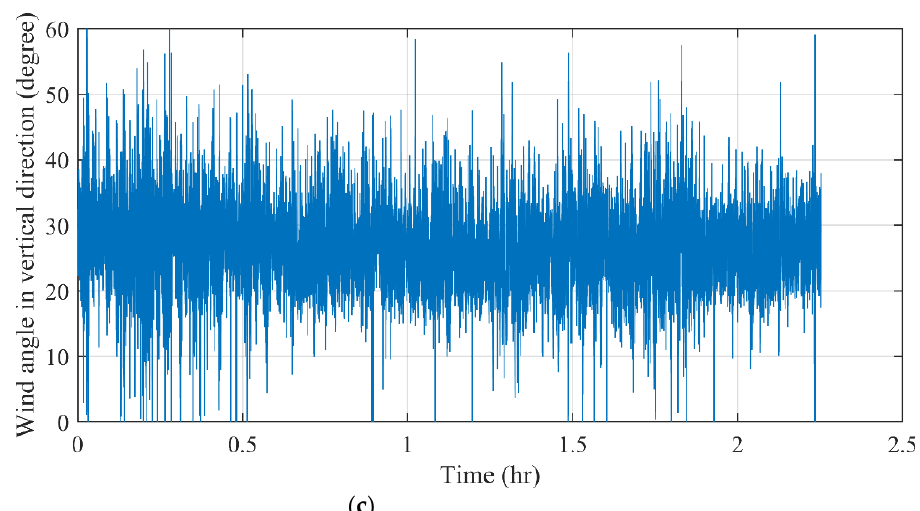
Figure 4. Time histories of wind speed, wind direction, and wind angle in vertical direction measured using ultrasonic anemometer (origin: 12:13 July 24): ( a ) wind speed; ( b ) wind direction; ( c ) wind angle in the vertical direction.